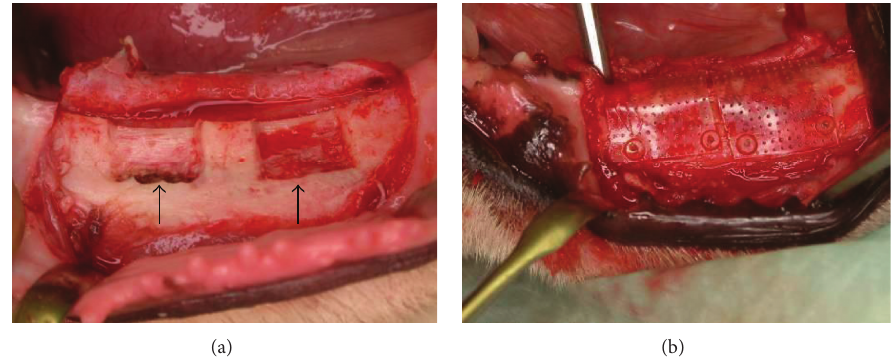
Figure1:GuidedboneregenerationwithPLGCmacroporousmembraneinlateralbonedefectsofacaninemandible[33].Clinicalappearance ofthesurgicallycreatedbonedefectsandmembraneplacement.(a)Intraoperativeviewofthetwolateralbonedefectscreatedinthemandible, and (b) view of the PLGC macroporous membrane closely adapted to the bone and stabilized with PLLA